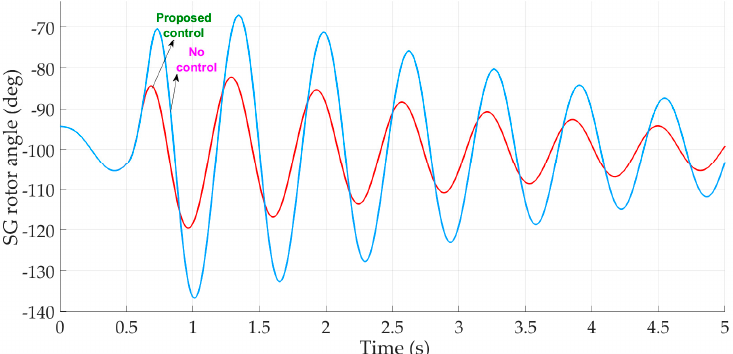
Figure 16. Synchronous generator (SG) rotor angle: no control (MPPT control) and proposed control.